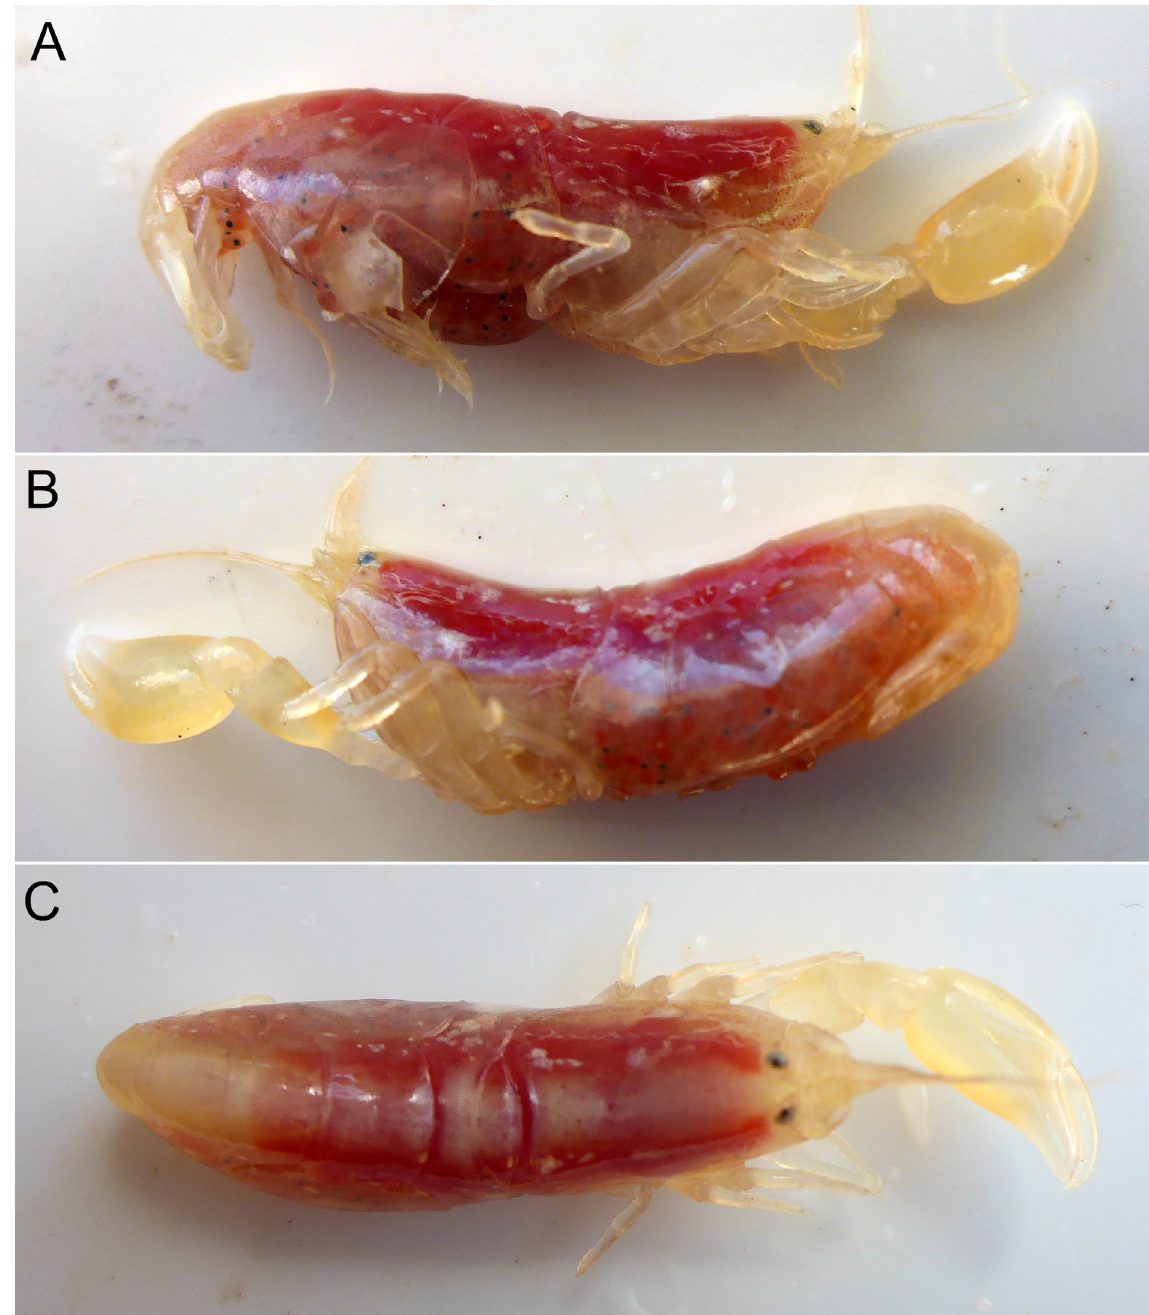
Fig. 4. Aretopsis sandybrucei sp. nov., paratype, ovigerous ♀ (cl 6.58 mm) from Argo Bank, Coral Sea (MNHN-IU-2017-2770), shrimp missing right (minor) cheliped, photographed shortly after collection. A . Right lateral view. B . Left lateral view. C . Dorsal view. Photographs by Dr. Sarah